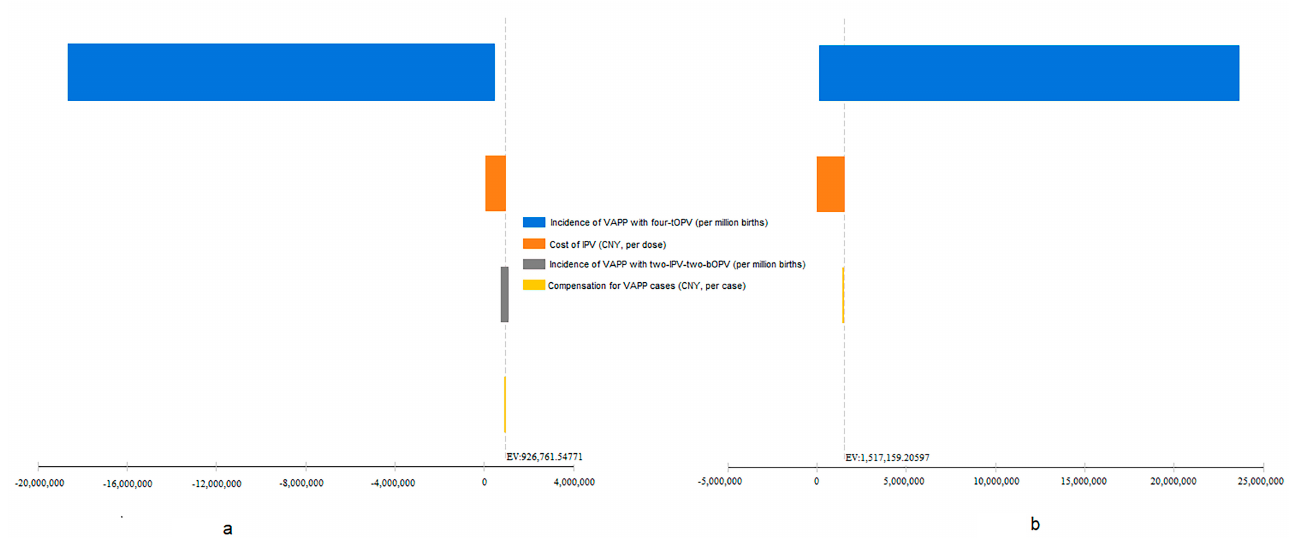
Figure 3. Tornado plot of the two-IPV-two-bOPV ( a ) and the four-IPV ( b ) immunization schedules, compared to the four-tOPV schedule, using univariate sensitivity analysis. The X -axis represented ICER LY . The incidence of VAPP cases with the four-tOPV schedule, incidence of VAPP cases with the two-IPV-two-bOPV schedule, compensation cost of VAPP cases, and cost of IPV were included in the analysis according to the range of values (Table 1). Positive and negative associations were further determined by the estimation of ICER, which were not presented in the figure. bOPV, bivalent live attenuated oral polio vaccine; tOPV, trivalent live attenuated oral polio vaccine; ICER, incremental cost-effectiveness ratio; IPV, inactivated polio vaccine; LY, life year; VAPP, vaccine-associated paralytic poliomyelitis.